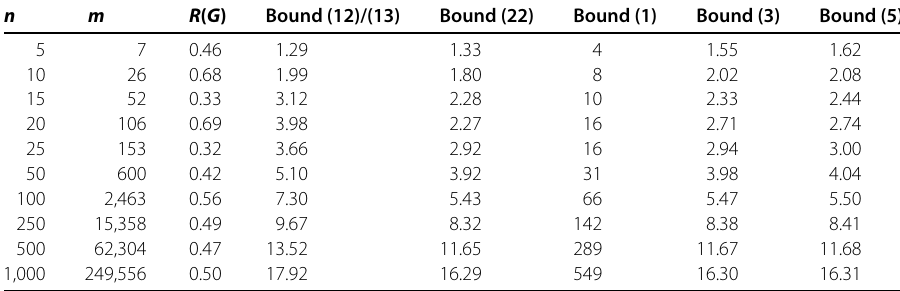
Table 1 Upper bounds of R ( G ) for graphs generated by G ER ( n ,0.5) model n m